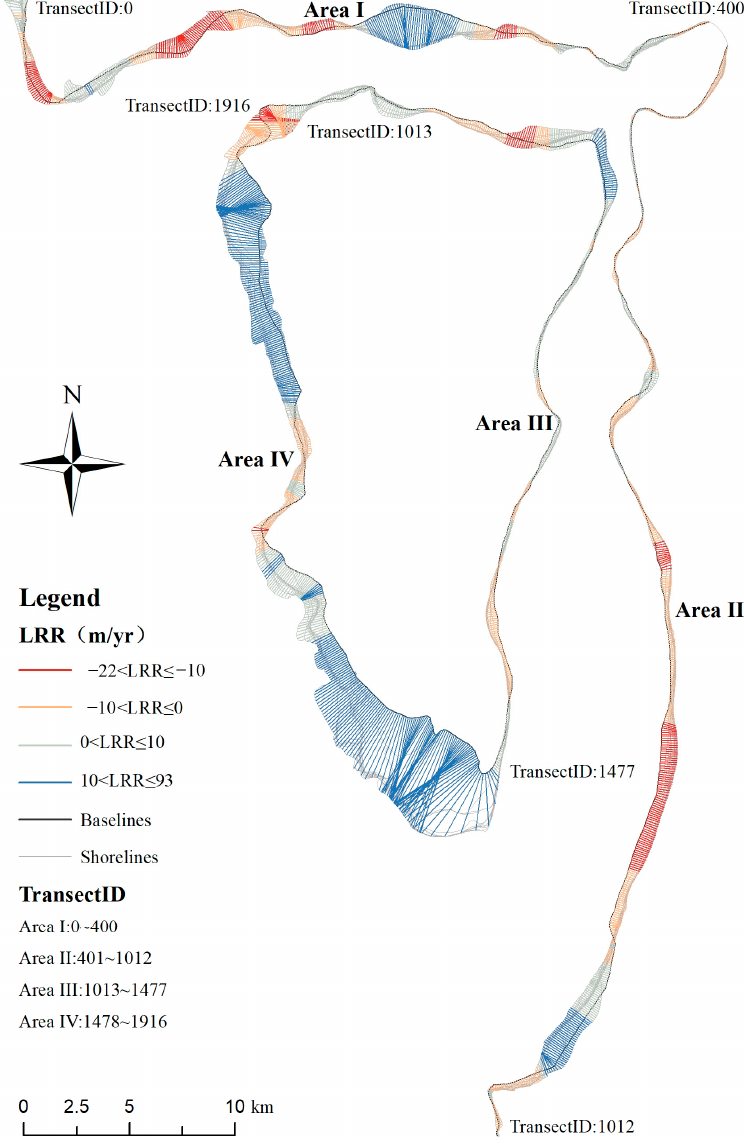
Figure 4. The Linear Regression Rate (LRR) of continental Bilu Island coastlines; red indicates coastline movement towards the continent (receding coastline); blue indicates coastline expansion toward the ocean.